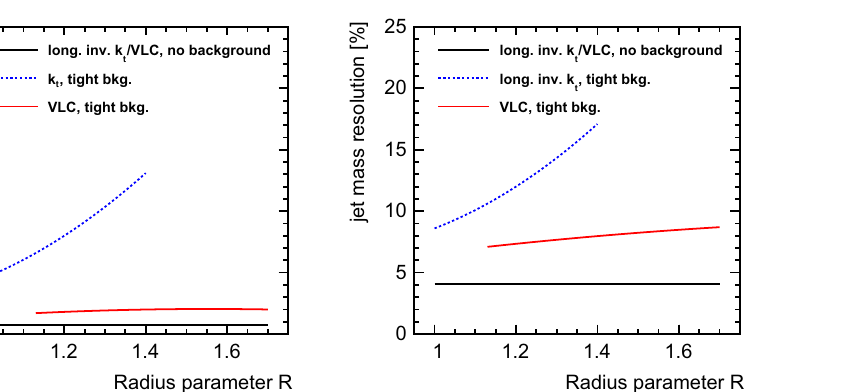
to jets reconstructed from all stable particles from the signal event. The black curves correspond to the results obtained without background, the blue dashed and red curves to 60 bunch crossings of γγ → hadrons background overlaid on the signal, with the tight PFO